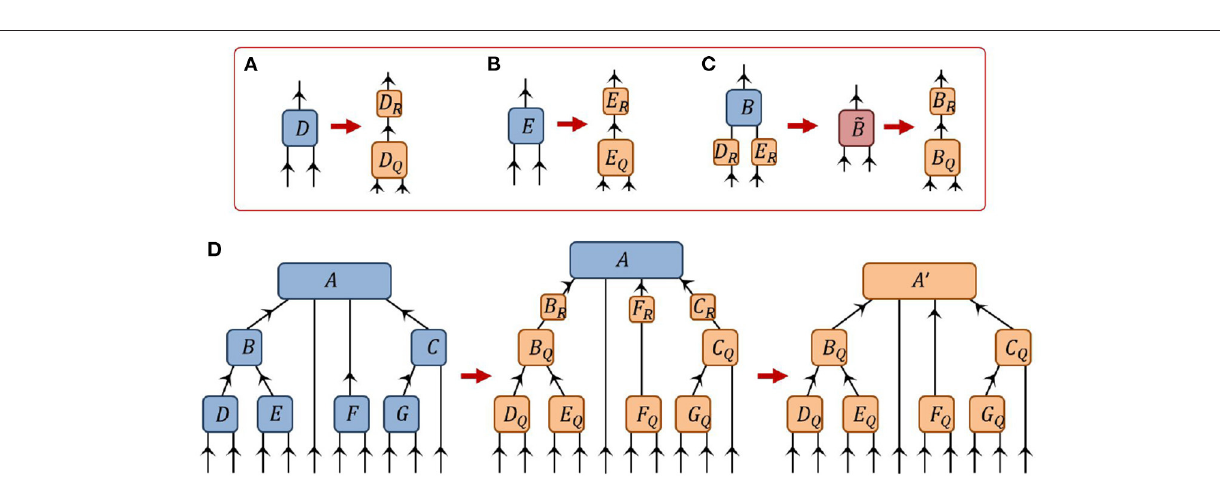
FIGURE 10 | A depiction of how the tensor A can be made into an orthogonality center of the network from Figure 7 via the “pulling-though” approach. (A,B) Tensors D and E , which reside at the tips of a branch, are decomposed via the QR decomposition. (C) The R components of the previous QR decompositions are absorbed into the B tensor higher on the branch, which is then itself decomposed via the QR decomposition. (D) Following this procedure, all tensors in the network are orthogonalized (with respect to their incoming vs. outgoing indices) such that A ′ becomes an orthogonality center of the